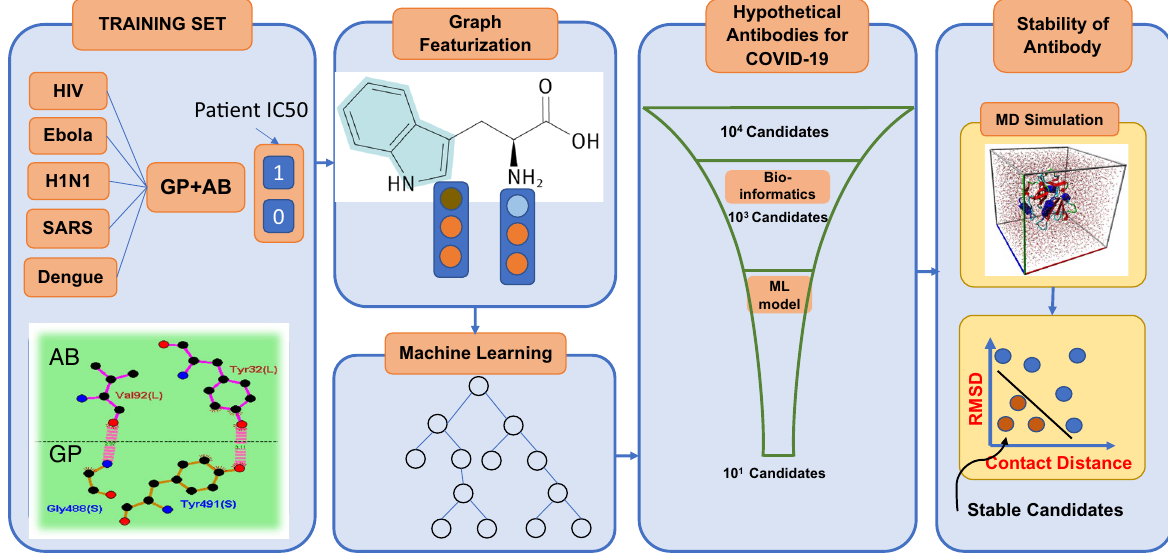
Figure 1. Designing antibodies or peptide sequences that can inhibit the SARS-CoV-2 virus requires high throughput experimentation of vastly mutated sequences of potential inhibitors. The screening of thousands of available strains of antibodies are prohibitively expensive, and not feasible due to lack of available structures. However, machine learning models can enable the rapid and inexpensive exploration of vast sequence space on the computer in a fraction of seconds. We collected 1933 virus-antibody sequences with clinical patient IC 50 data. Graph featurization of antibody-antigen sequences creates a unique molecular representation. Using